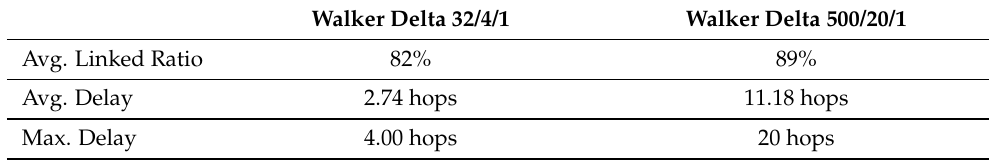
Figure 14. Topology switches of the two constellations. Table 5. The average linked ratio, the average delay, and maximum delay of the two